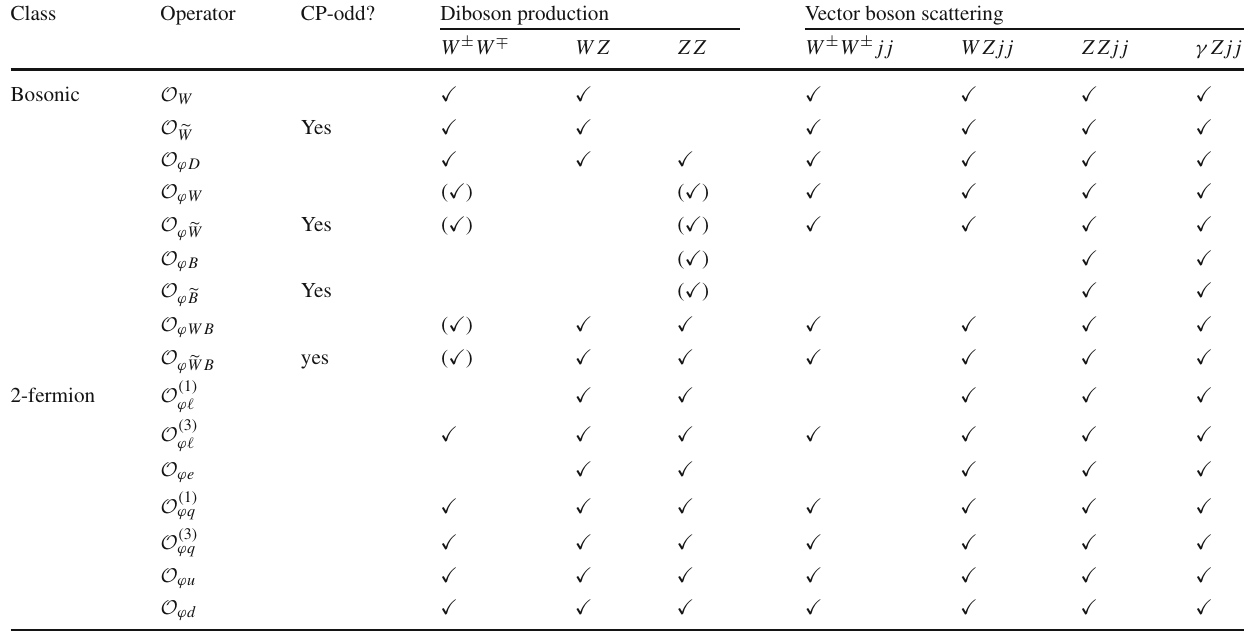
Table 7 We indicate which of the n op = 16 dimension-six EFT opera- tors considered in this analysis contributes to which of the experimental datasets.Furthermore,with ( (cid:3) )